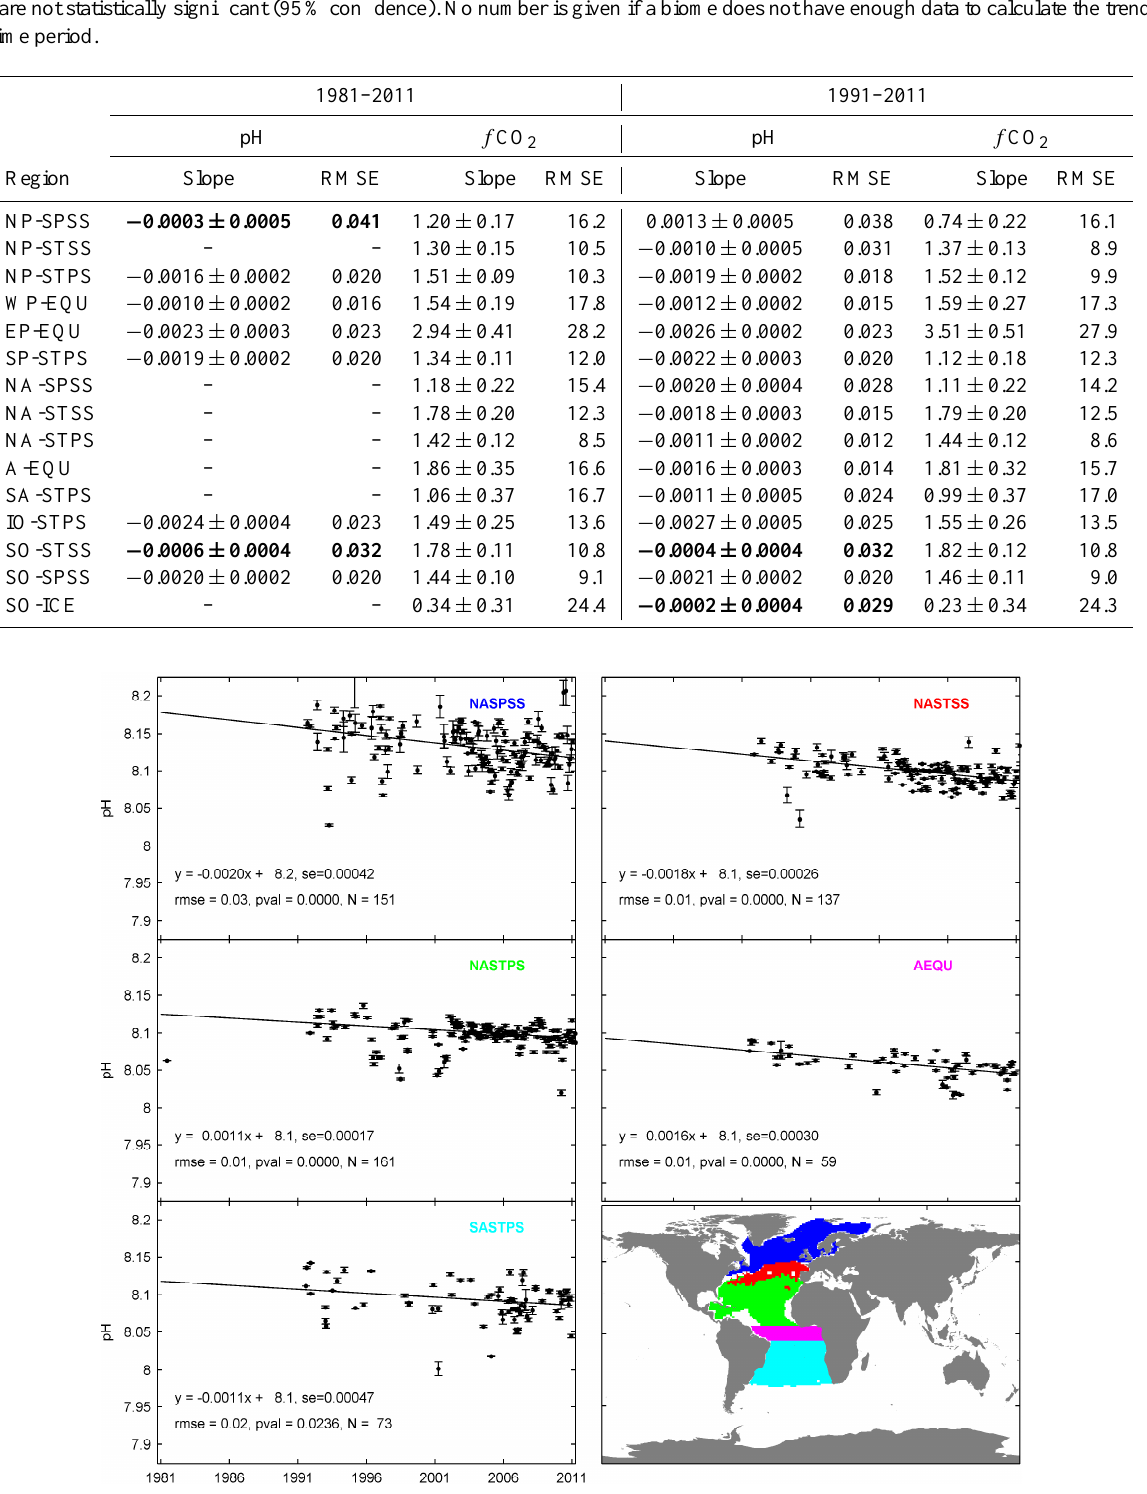
Figure 2. Long-term pH trend (1981–2011) in the five Atlantic Ocean